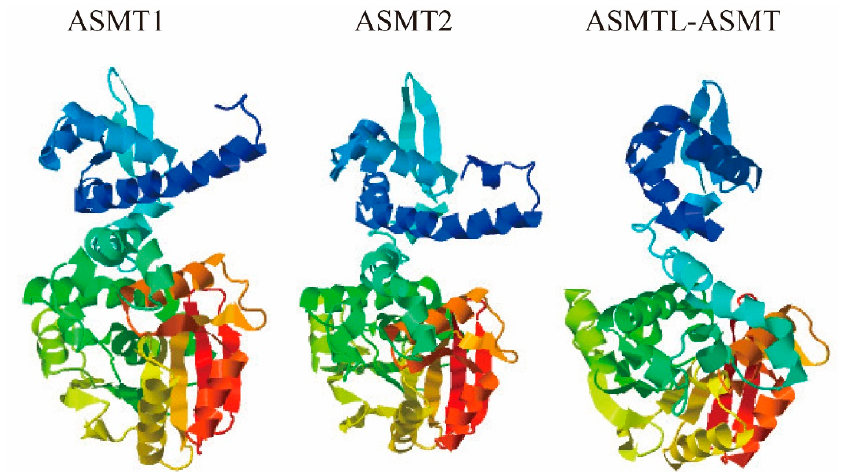
Figure 6. Predicted 3D models of ASMT1, ASMT2 and ASMTL-ASMT from BP